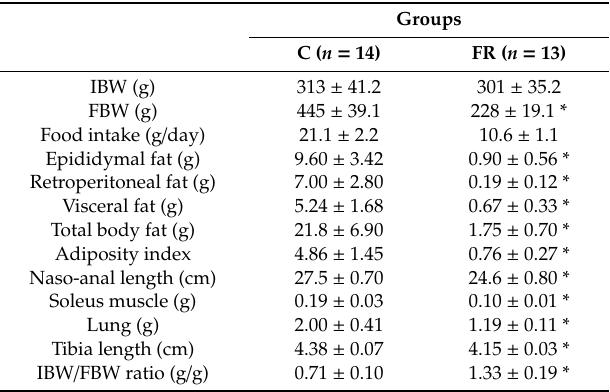
Table 1. Physical characteristics of